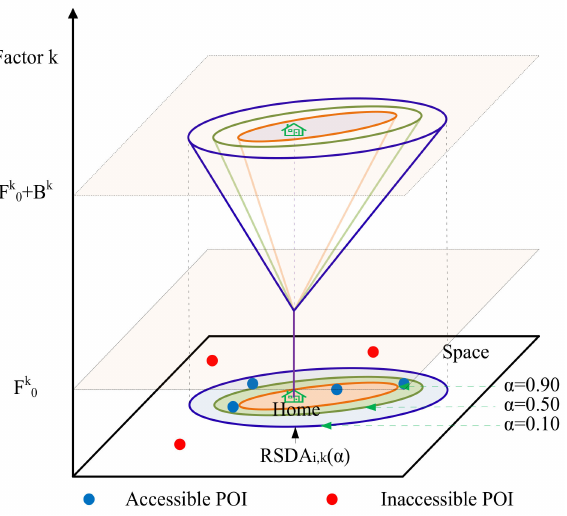
Figure 4. The bi-objective opportunity model: F k